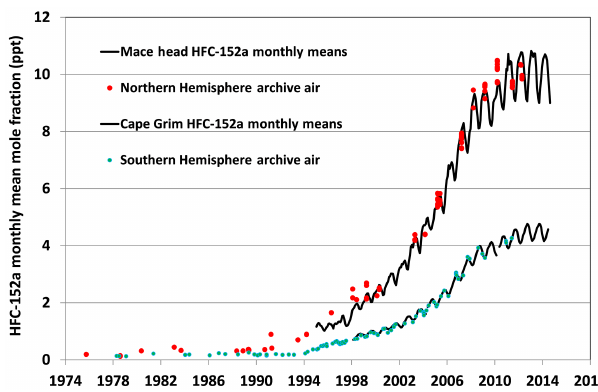
Figure 3. HFC-152a baseline monthly mean mole fraction (ppt) recorded at Mace Head-MHD (ADS GC-MS, 1994–2003; Medusa GC-MS, 2004–2014) and at Cape Grim-CGO (ADS GC-MS, 1998– 2003; Medusa GC-MS, 2004–2014) and from analysis of archived NH and SH air samples extending back to 1975: in situ (black), air archive NH (red) and SH